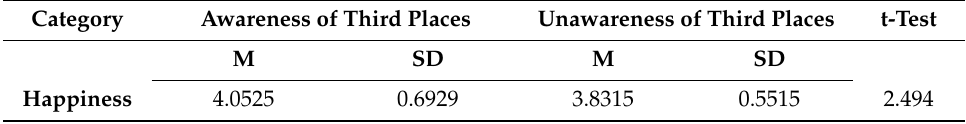
Table 2. Awareness of third places and the mean of happiness (based on 6.0